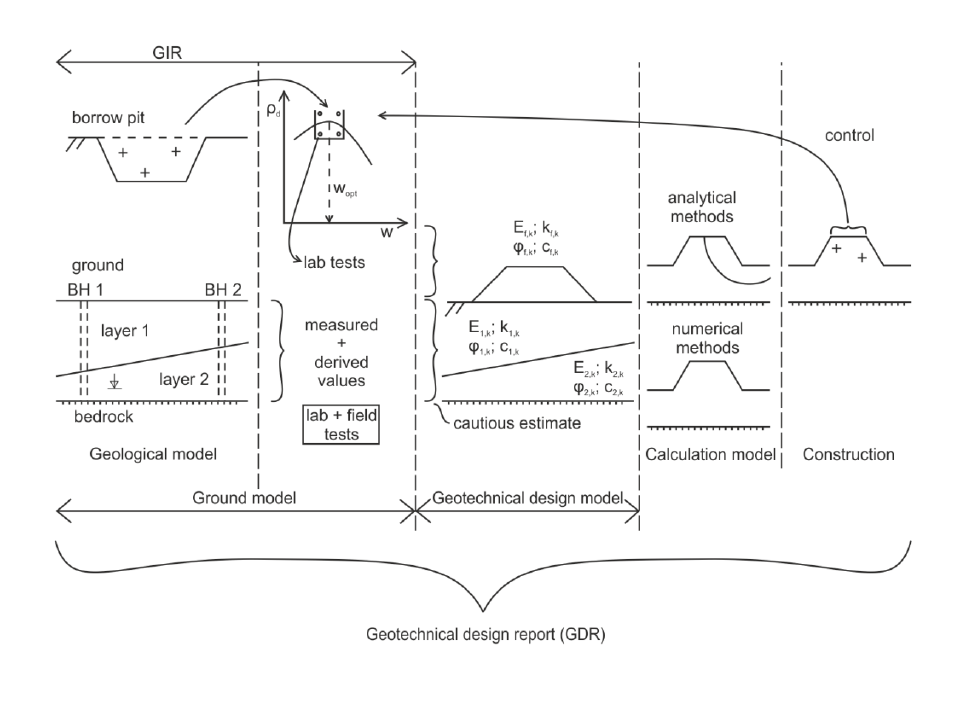
Figure 3. Geotechnical Design Report